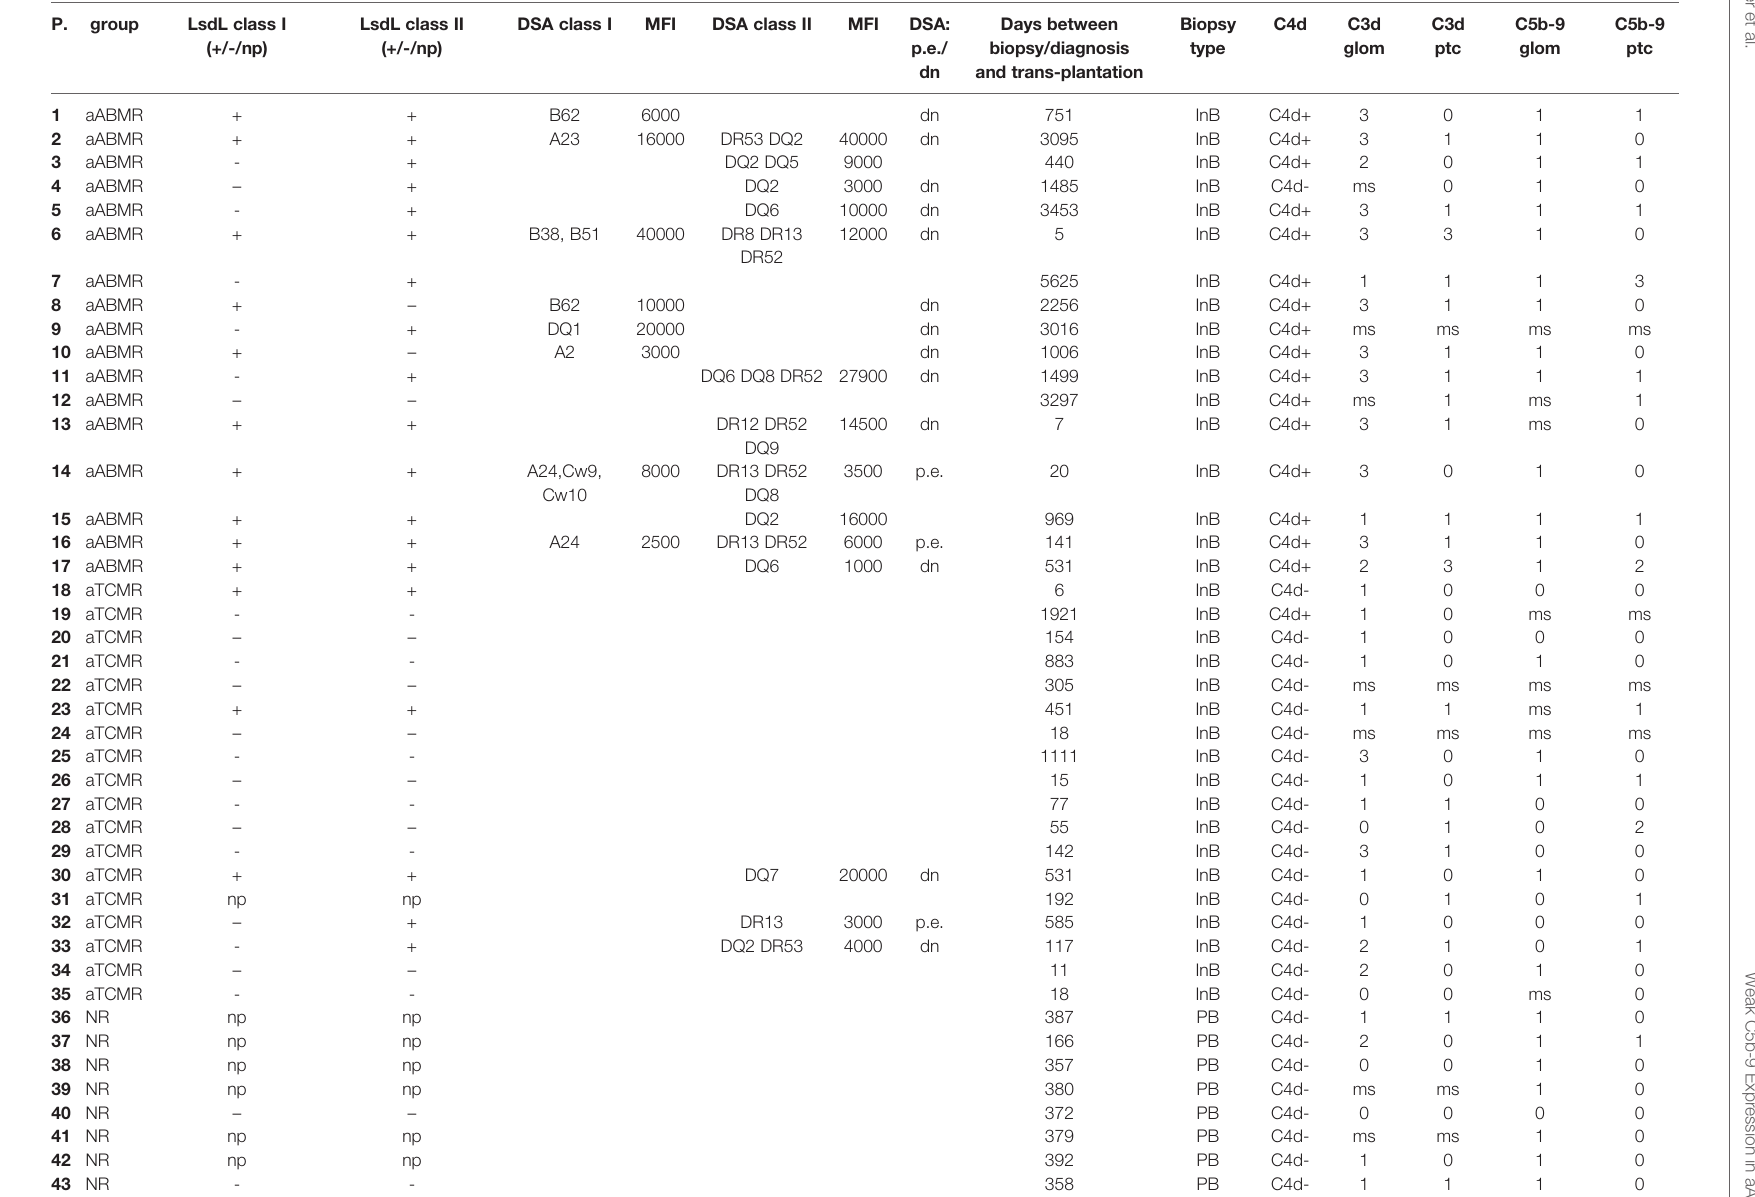
TABLE 5 | Detailed immunological, histopathological and clinical information of individual patients included. P.